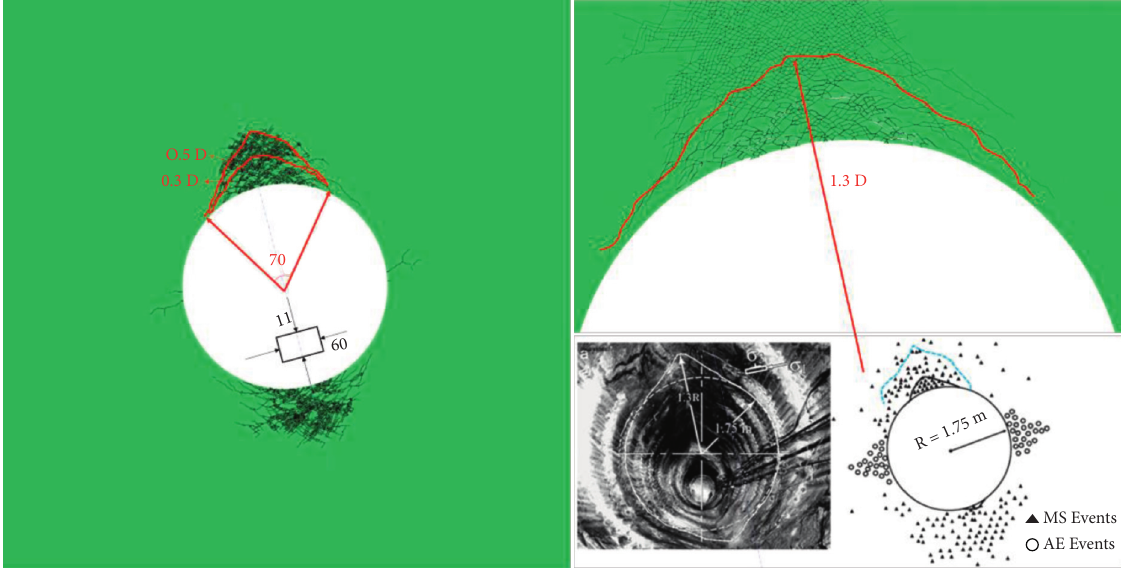
Figure 9: Comparison between simulated and observed